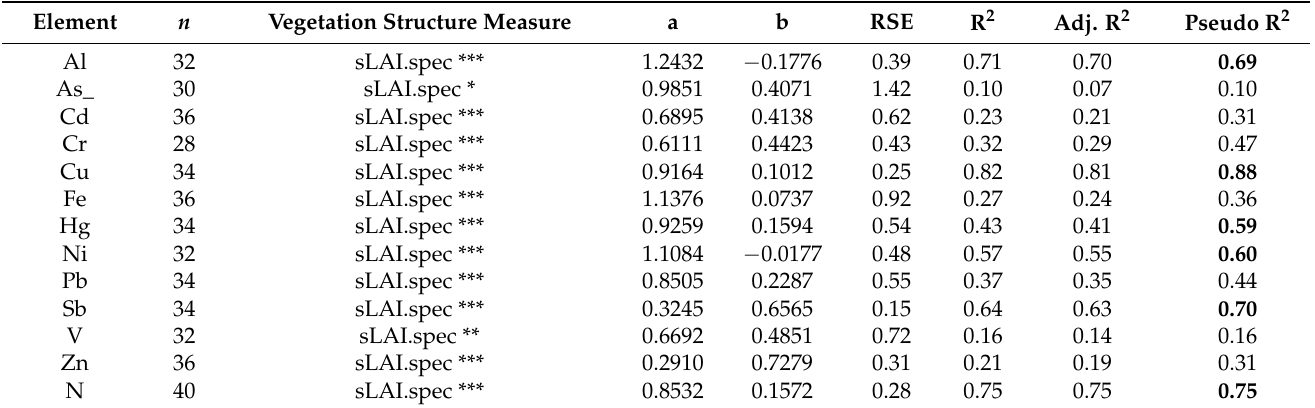
Table 9. Characteristics and goodness-of-fit measures of the regression models for the relationship between the quotients of the element contents in the mosses and the quotients of the simple tree species-specific leaf area